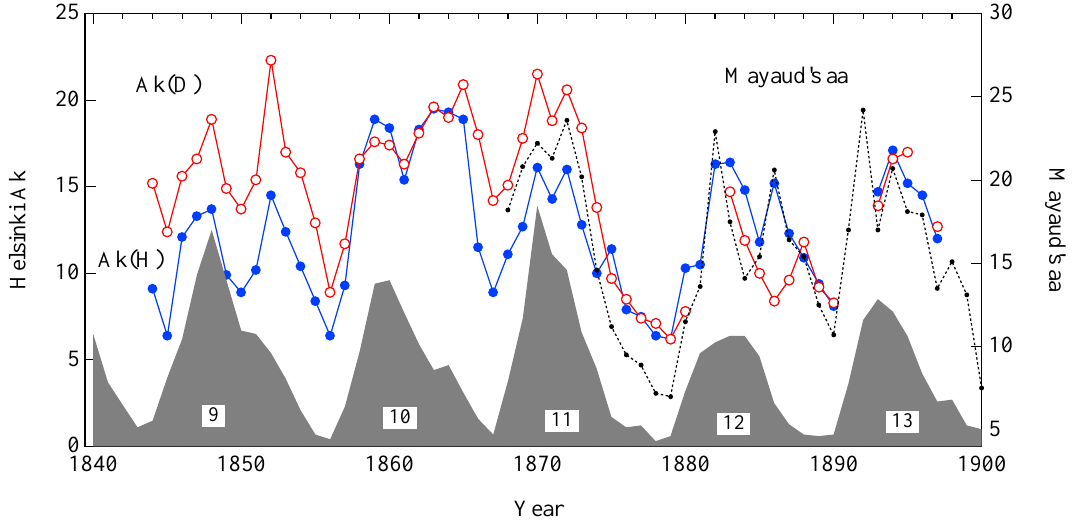
Fig. 3. Annual values of activity indices. Ak(H) (blue) and Ak(D) (red) are derived from the H - and D -components, respectively, using the Helsinki data. The calculation of the activity indices has been carried out by using the FMI-algorithm (Sucksdorff et al., 1991). The black line represents Mayaud’s activity index aa (starting in 1868). The dark area at the bottom shows annual means of sunspot numbers. The labels attached with sunspots are numbers of solar